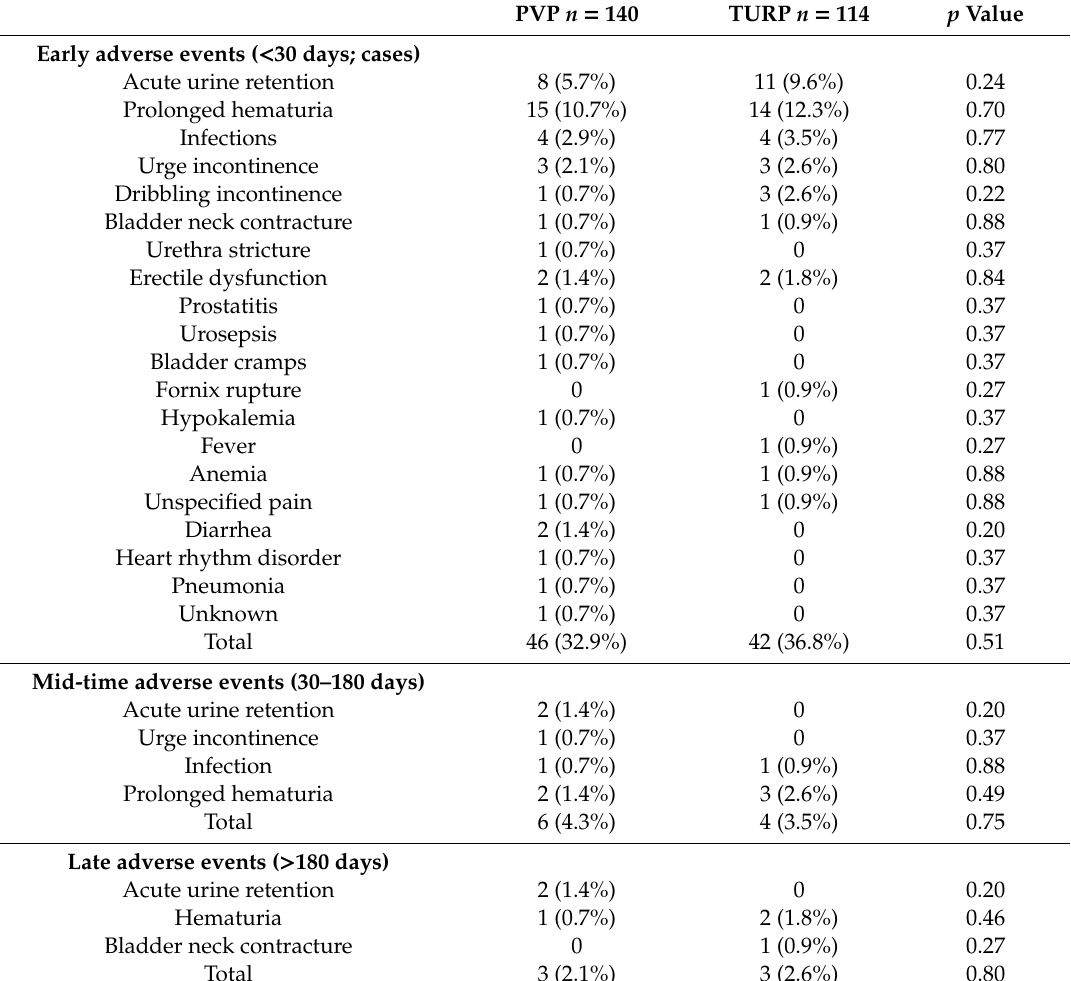
Table 3. Adverse events (early, mid-time, and